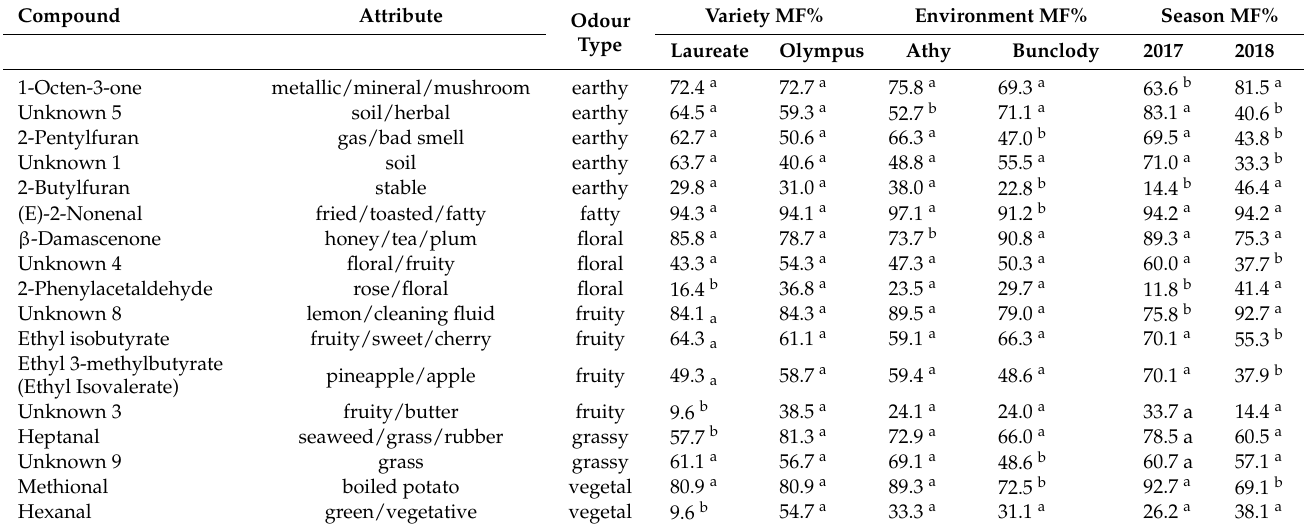
Table 2. Aroma active compounds affected by variety (Laureate and Olympus), environment (Athy and Bunclody), or season (2017 and